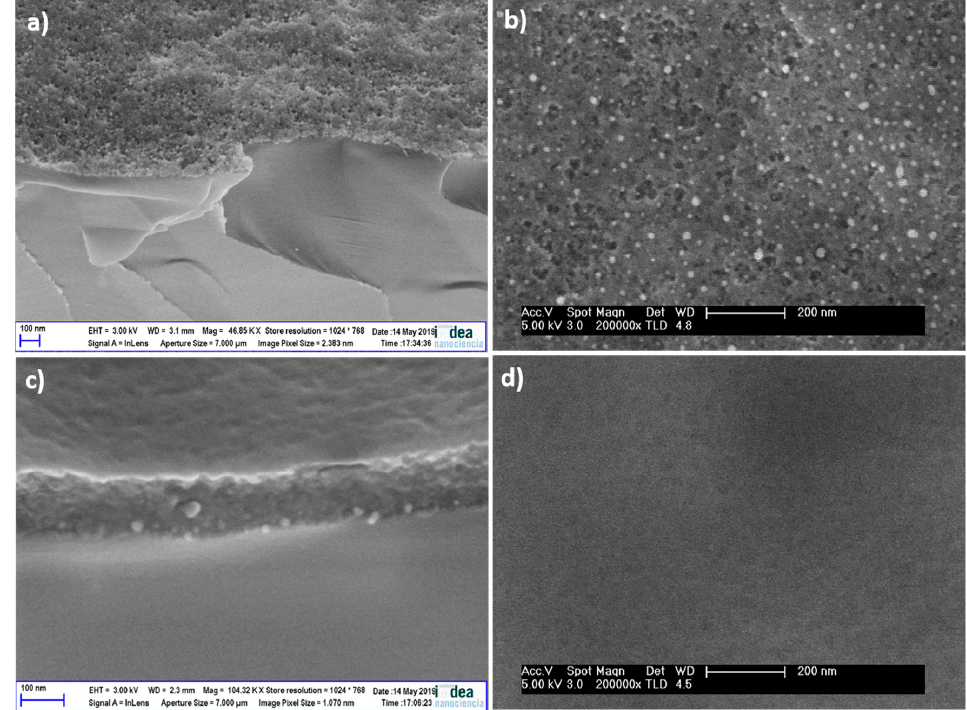
Figure 2. ( a ) Cross-sectional, and ( b ) top views FESEMimages of a typical nanoPS + AgNPs layer ( c ), and ( d ) the same views upon deposition of a conformal TiO 2 thin film.